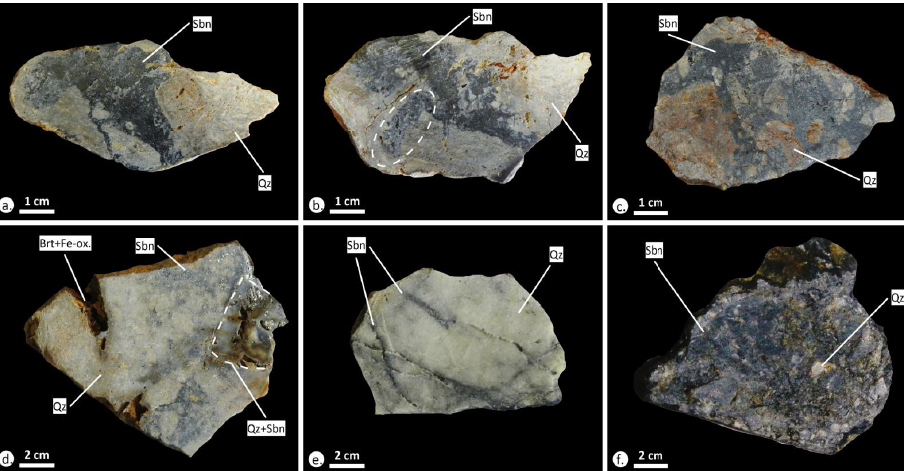
Figure 7. Hand specimens from the Sb±W-mineralization at Rizana: ( a ) Massive stibnite (Sbn) cementing brecciated saccharoidal quartz (Qz); ( b ) Massive stibnite (Sbn) cementing locally micro- brecciated (dashed line) saccharoidal quartz (Qz); ( c ) Hydrothermal breccia consisting of stibnite (Sbn) and angular to rounded quartz (Qz) fragments of various sizes; ( d ) A fragment of semi-transparent quartz (Qz) with stibnite (Sbn) cemented by saccharoidal quartz (Qz) containing disseminated stibnite (Sbn). A vague is filled with barite (Brt) euhedral crystals covered by reddish Fe–oxides (Fe-ox.); ( e ) Stibnite (Sbn) filling cracks in quartz (Qz); ( f ) A silicified pod from two-mica gneiss including stibnite (Sbn) and rounded quartz (Qz) grains. Microscopically, stibnite is characterized by strong bireflectance and by complex pressure lamellae as a result of deformation (Figure 9a). It forms intergrowths with quartz. In the massive form, it appears cementing euhedral quartz, forming disseminations in quartz and filling cavities and interstices in quartz (Figure 9a – d). Acicular stibnite occurs as overgrowths on quartz. Minor chalcopyrite, sphalerite and pyrite, not exceeding <700 μm in w idth, are found in cavities in stibnite masses (Figure 9b,d). Euhedral pyrite (<400 μm in width) and arsenopyrite (<200 μm in width) are found in quartz (Figure 9d,e). Lo- cally, aggregations of euhedral pyrite showing cataclasis occur in angular quartz grains where ankerite is present in cavities (Figure 9f). Berthierite, barite and native antimony are found as inclusions (<100 μm in width) in stibnite and quartz, while valentinite (<50 μm in width) occurs in association with stibnite and berthierite (Figure 10a,b). Locally, sphalerite (<300 μm) is rimmed by ankerite and contains tetrahedrite inclusions, while claudetite and native arsenic occur closely related in quartz (Figure 10c).